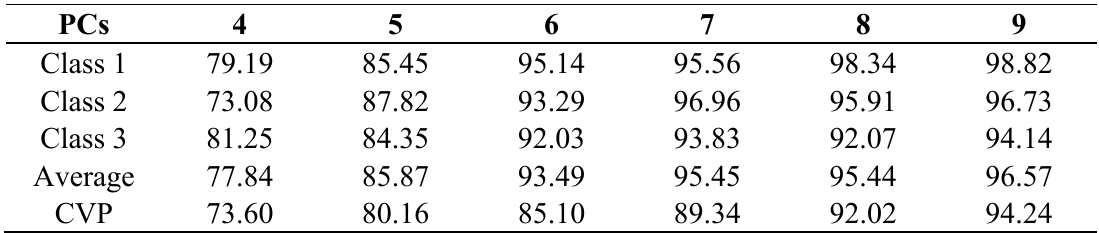
Table 1. The classification performance of the KIII model with the increase of the dimension of input feature vector.